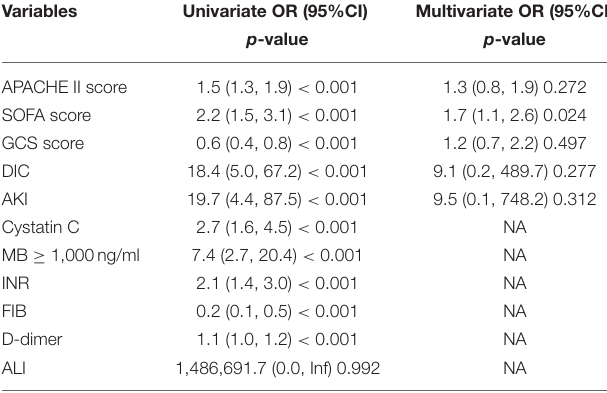
TABLE 3 | The relationship between RM and another organ injury in EHS. Variables